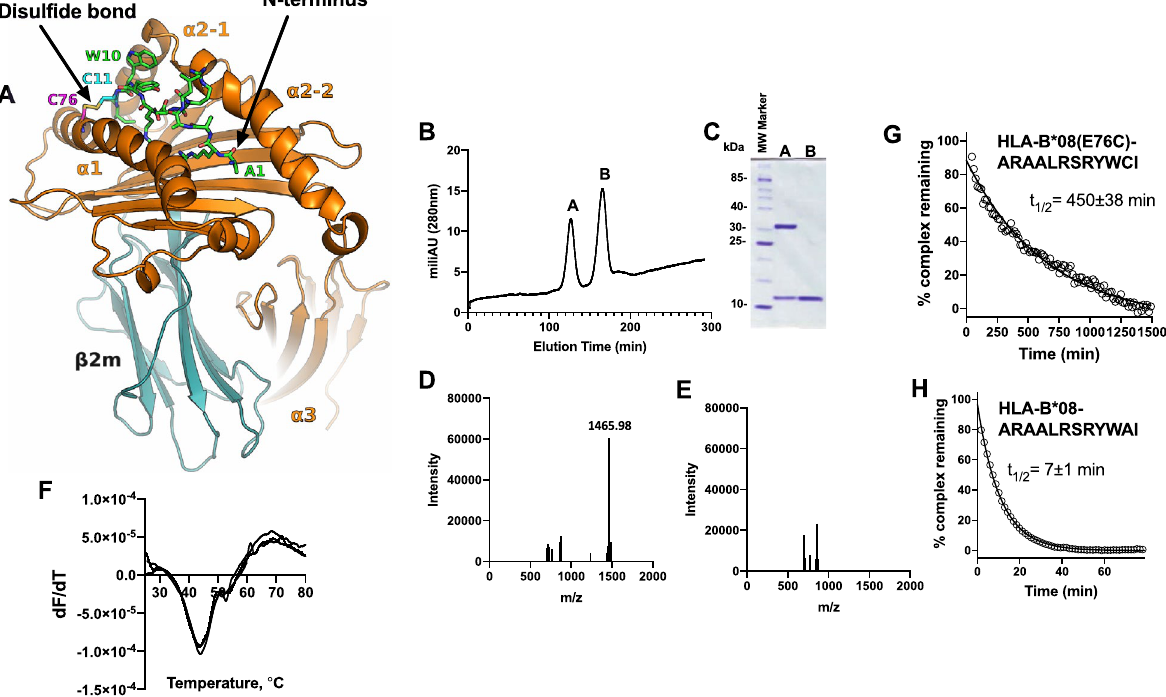
Figure 1. Construction and validation of a disulfide-linked HLA-B*08/peptide complex. Panel ( A ), molecular model of the HLA-B*08(E76C)-ARAALRSRYWCI complex (peptide shown in green sticks, disulfide bond between the HLA residue Cys76 and peptide residue Cys11, is indicated). Panel ( B ), size-exclusion chromatogram after refolding of HLA-B*08(E76C) with the peptide ARAALRSRYWCI. Panel ( C ), SDS-PAGE of peaks A and B of chromatogram shown in Panel ( B ). Panel ( D ), MALDI-TOF–MS of purified complex in the presence of 100 mM DTT. Panel ( E ), MALDI-TOF–MS of purified complex in the absence of DTT. Panel ( F ), 1st derivative of thermal shift assay of purified complex (three repetitions shown). Panel ( G ), kinetic analysis of binding of SYPRO Οrange to purified complex HLA-B*08(E76C)-ARAALRSRYWCI (each data point is the average of three repetitions). Panel ( H ) Kinetic analysis of binding of SYPRO Οrange to non-covalent complex HLA-B*08 – ARAALRSRYWAI (each data point is the average of two